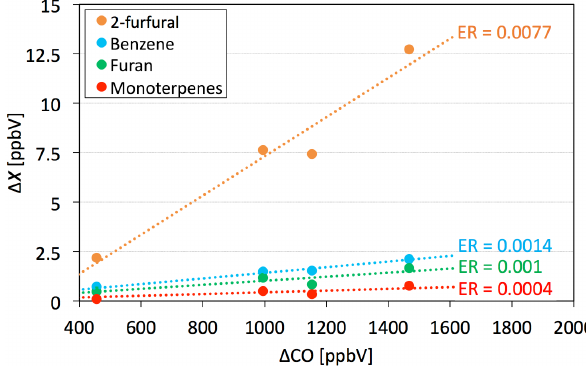
Figure 4. Average excess VMRs of 2-furfural, benzene, furan, and monoterpenes vs. average excess VMRs of CO. Each data point represents data from one fire overflight (source emission profile). The slopes of the least-square regressions (dotted lines) correspond to the initial molar emission ratios (ER X / CO , in ppbVppbV − 1